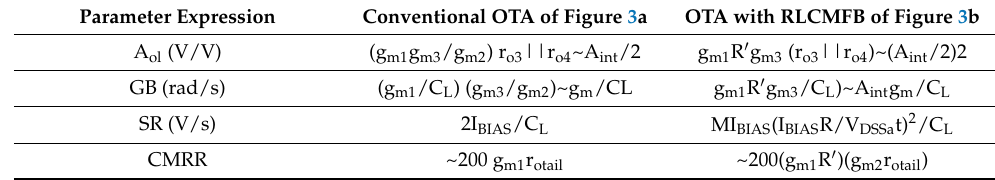
Table 1. Basic performance characteristics of OTAs of Figure